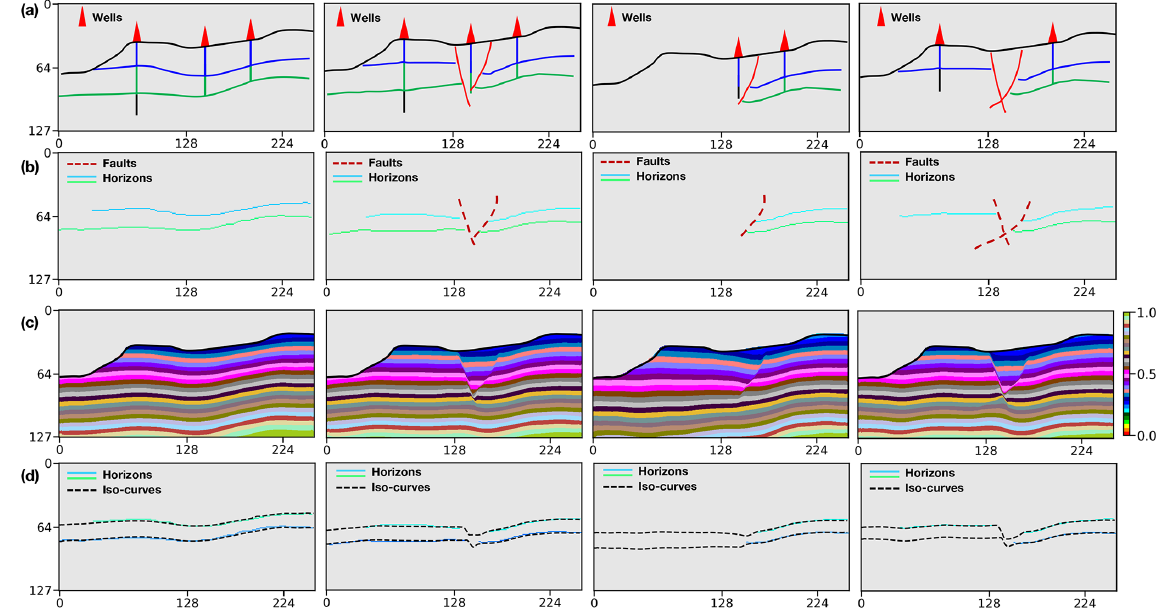
Figure 13. Geological uncertainty analysis. We display multiple sets of modeling elements interpreted from the vertical boreholes and the outcrop observations (a) , input horizon and fault data (b) , modeling results (c) , and iso-curves extracted from the predictions (d) , respectively.